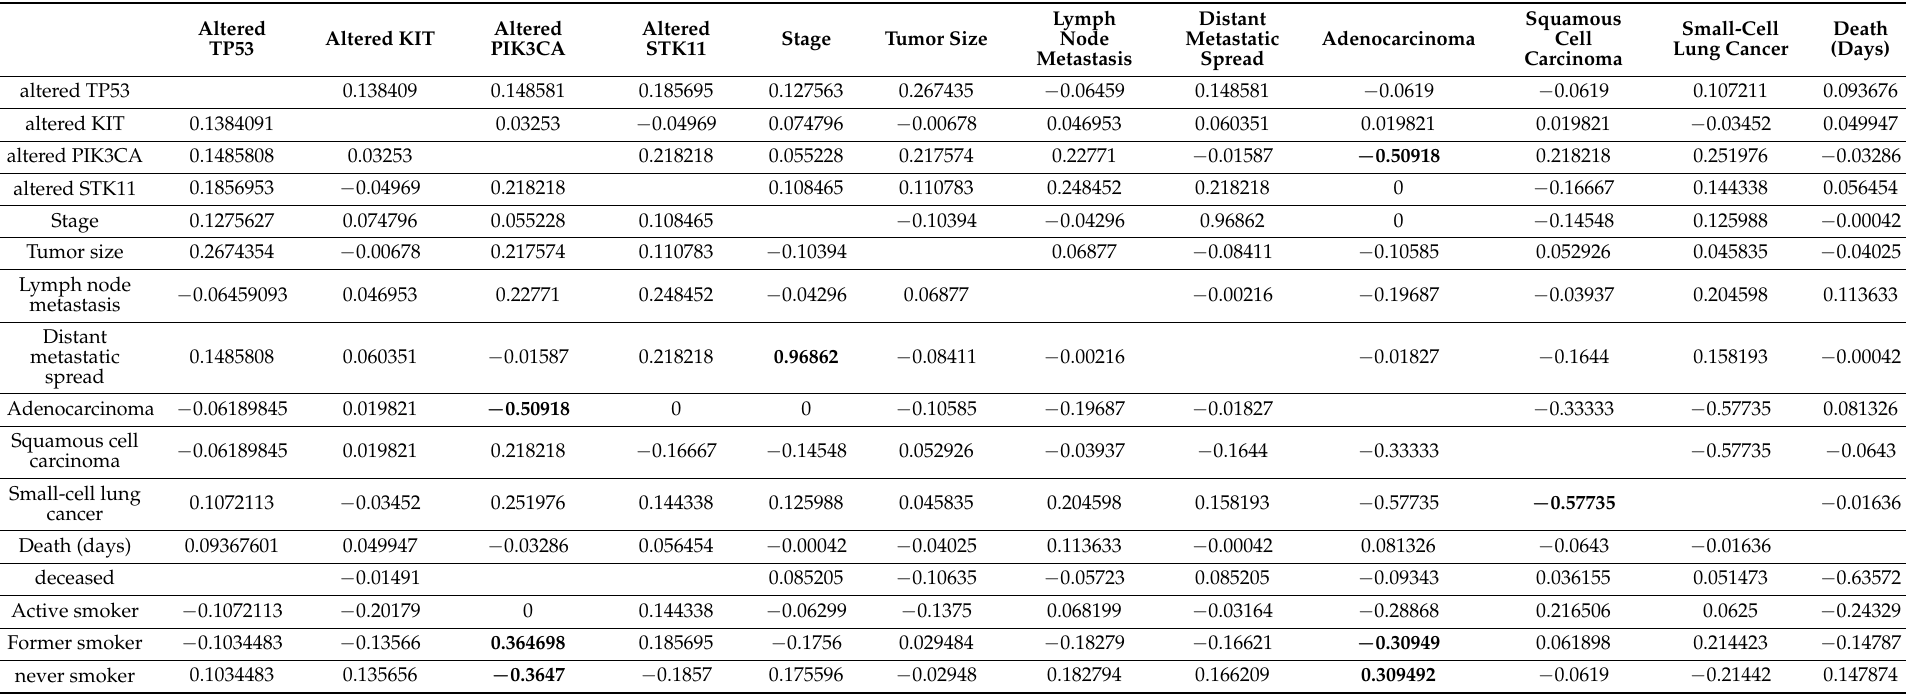
Table 5. Correlation coefficients (r) for lung cancer patients between the following criteria: alterations in TP53, KIT, PIK3CA, and STK11, tumor cancer stage, tumor size, lymph node involvement, metastatic spread and time to event